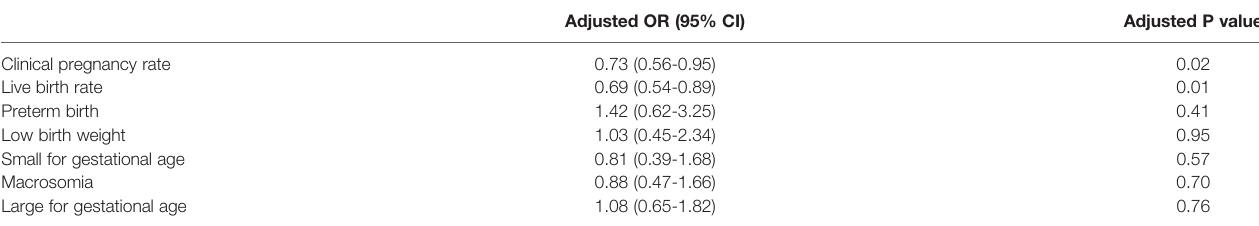
TABLE 4 | Adjusted odds ratio of the singleton clinical and neonatal outcomes of the surgically acquired and ejaculated sperm groups.